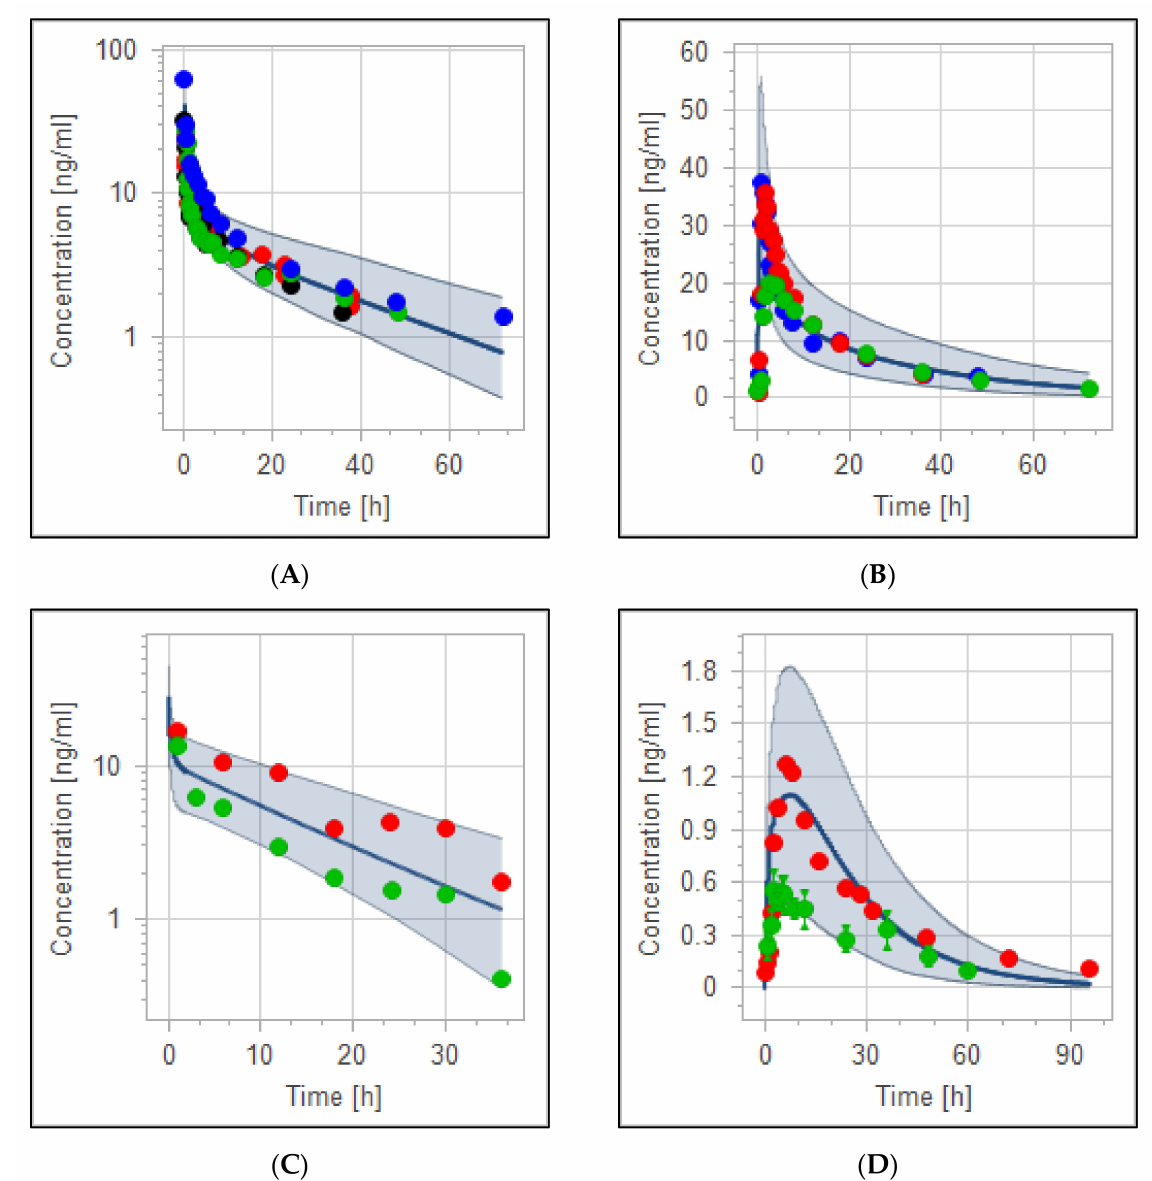
Figure 4. Visual verification of haloperidol population PBPK model. Observed data have been combined into one simulation according to the similarity in the dosage regimen and administration protocol. ( A ) PK profile of healthy and psychotic otherwise healthy populations after IV administra- tion with experimental data depicted as blue [42], green [40], red [43] and black [41] circles. ( B ) PK profile of adult healthy population after oral administration with experimental data being depicted as red [41], blue [40], and green [42] circles. ( C ) PK profiles of adult TB population (treatment-naïve) after haloperidol 5 mg IV with experimental data depicted as red and green circles [45]. ( D ) Adult healthy/psychotic otherwise healthy population after 5 mg oral haloperidol with observed data depicted as red [49] and green [73] circles. Blue solid lines and shaded areas illustrate simulation mean and the 2.5th to 97.5th prediction range,